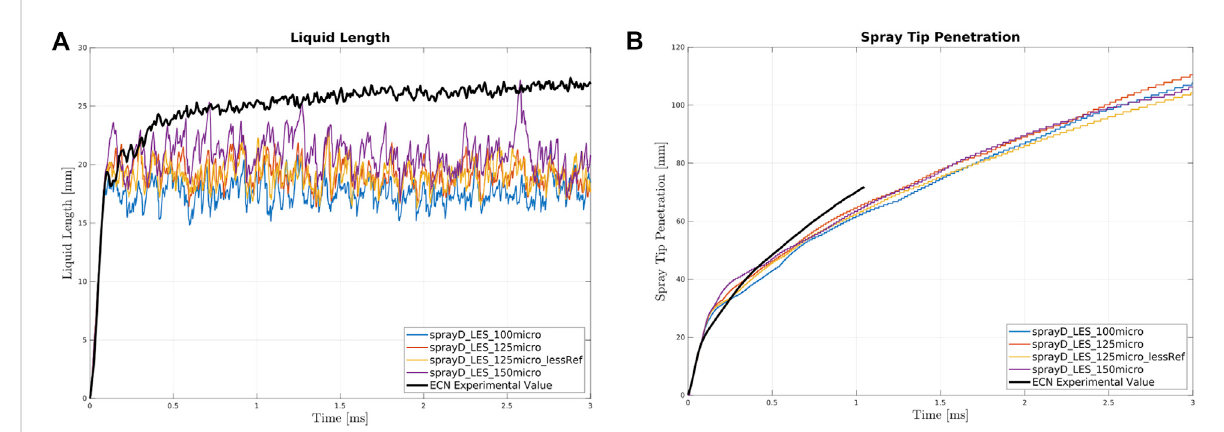
FIGURE 5 Liquid Length (A) and Spray Tip Penetration (B) for Spray D at various mesh